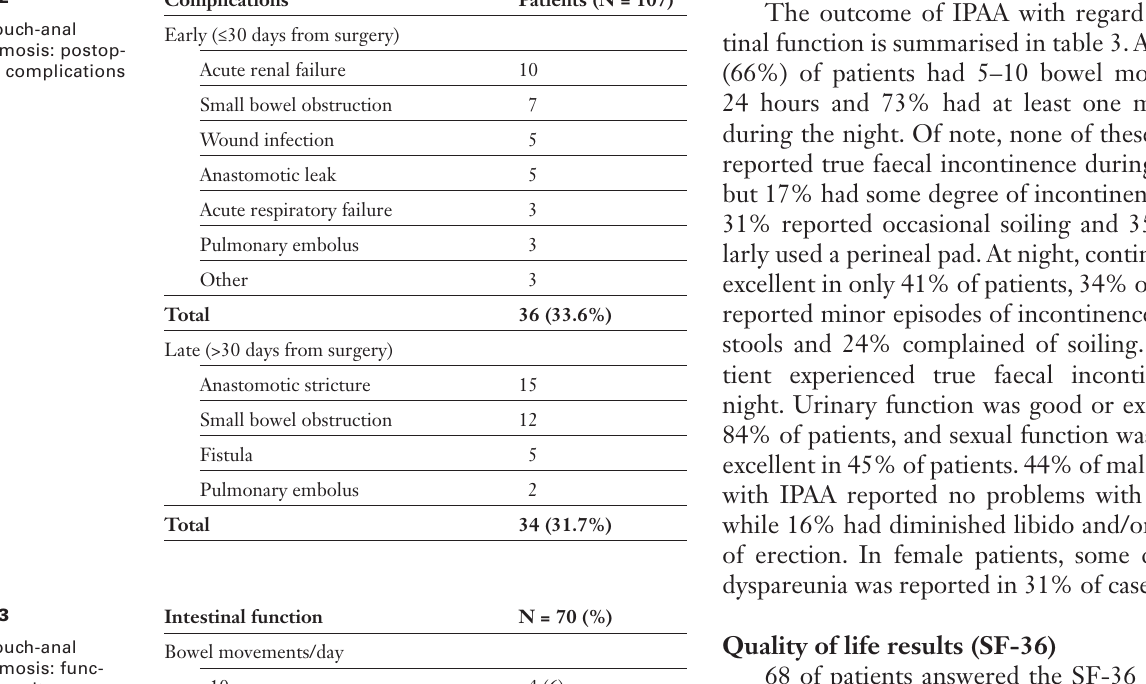
Ileal pouch-anal anastomosis: postop- erative complications